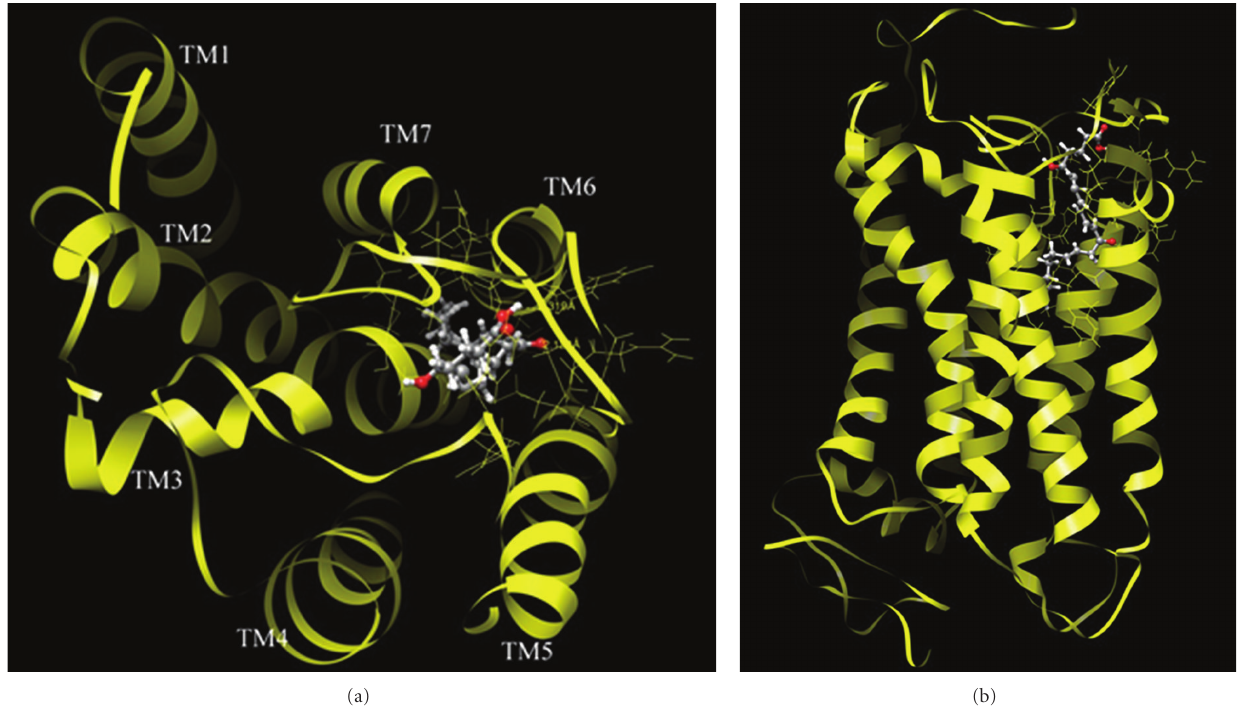
Figure 4: A best 3D structure of active-state